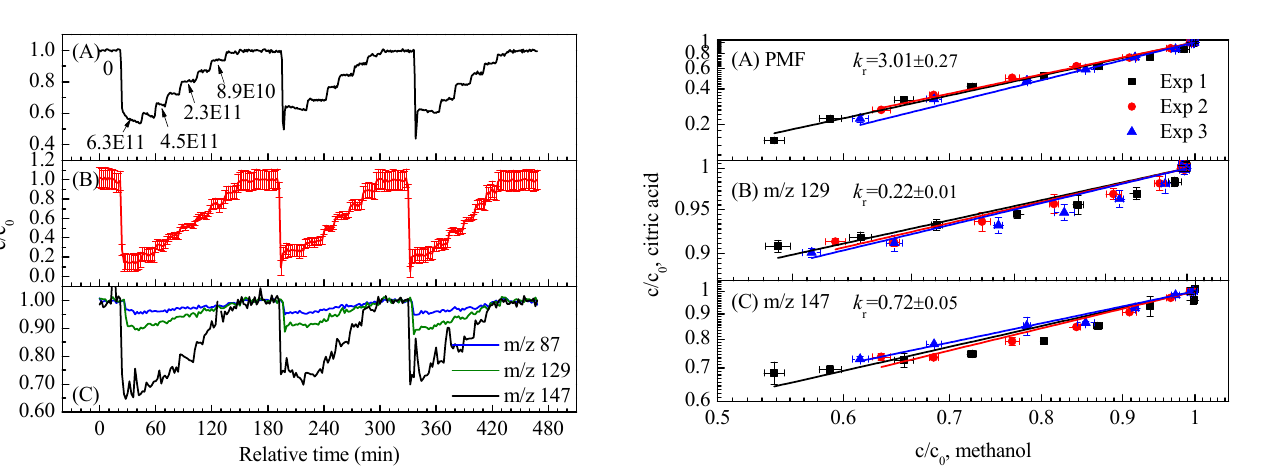
Figure 6. Relative concentration of citric acid ( c/c 0 ) as a function of the relative concentration of methanol based upon (a) PMF anal- ysis, (b) m/z = 129 and (c) m/z 147. Experimental conditions are D m : 140nm, RH: 30 ± 3%, T :